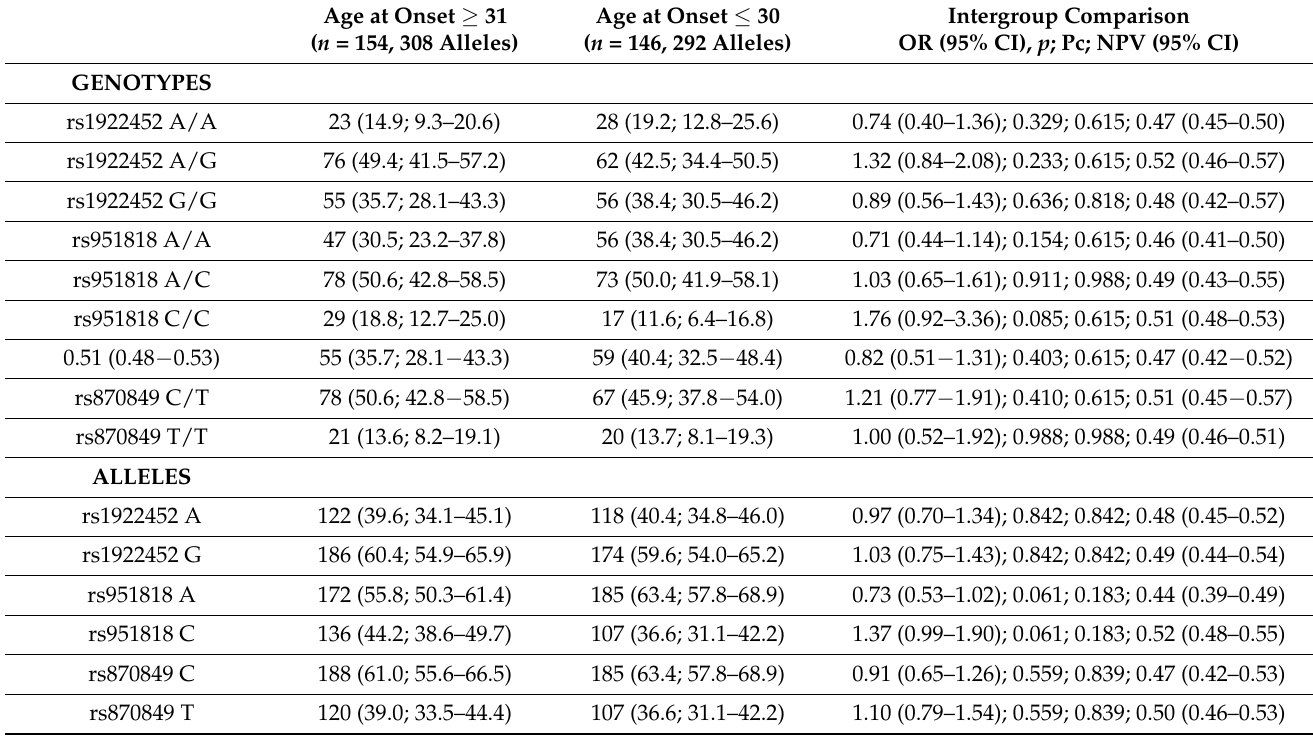
Table 3. Genotypes and allelic variants of patients with MS according to the age at onset. The values in each cell represent the number (percentage; 95% confidence intervals).